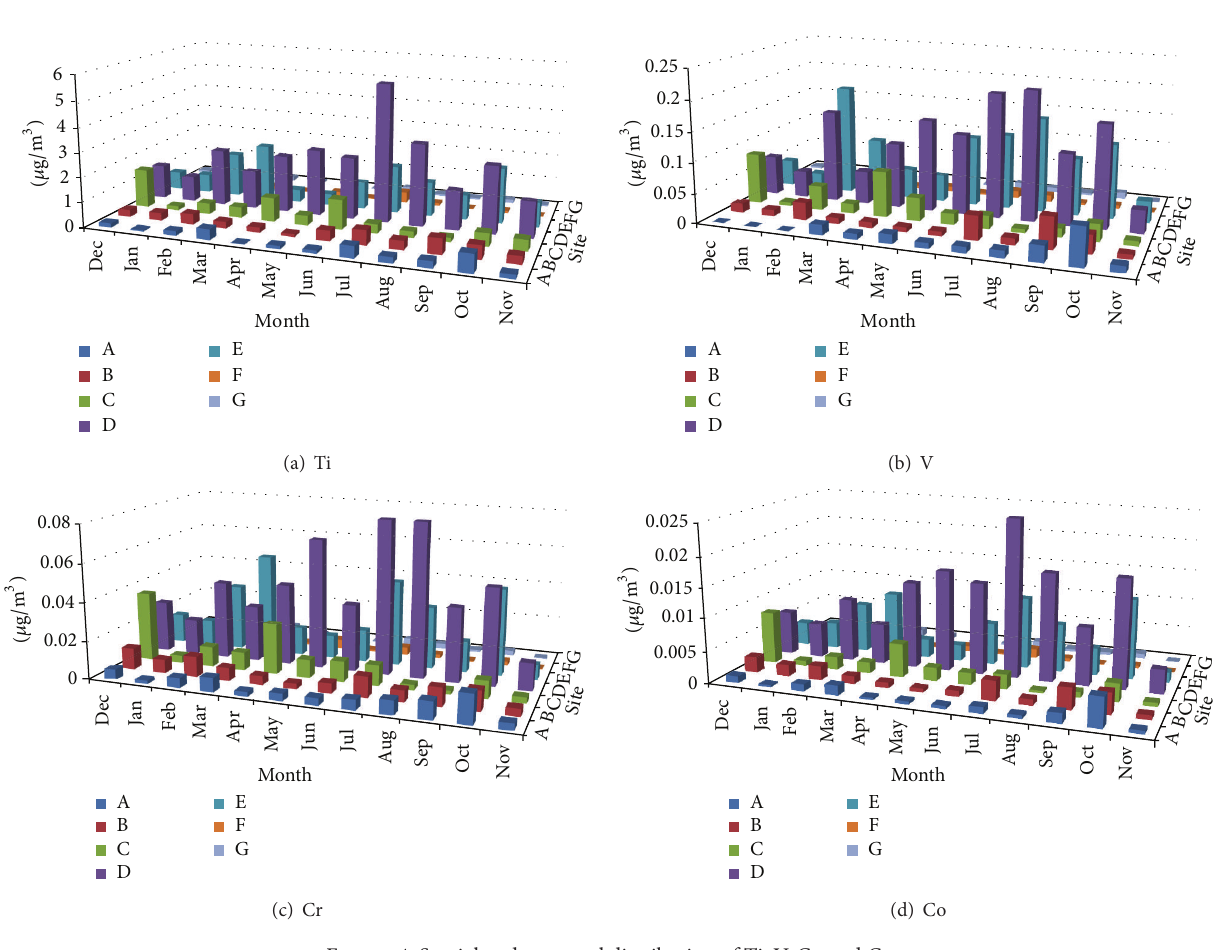
Figure 4: Spatial and temporal distribution of Ti, V, Cr, and Co.